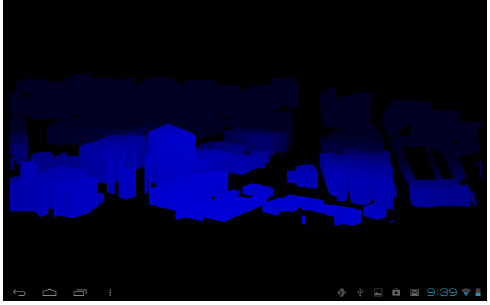
Figure 10: Sheffield - LoD 1 Dataset - City